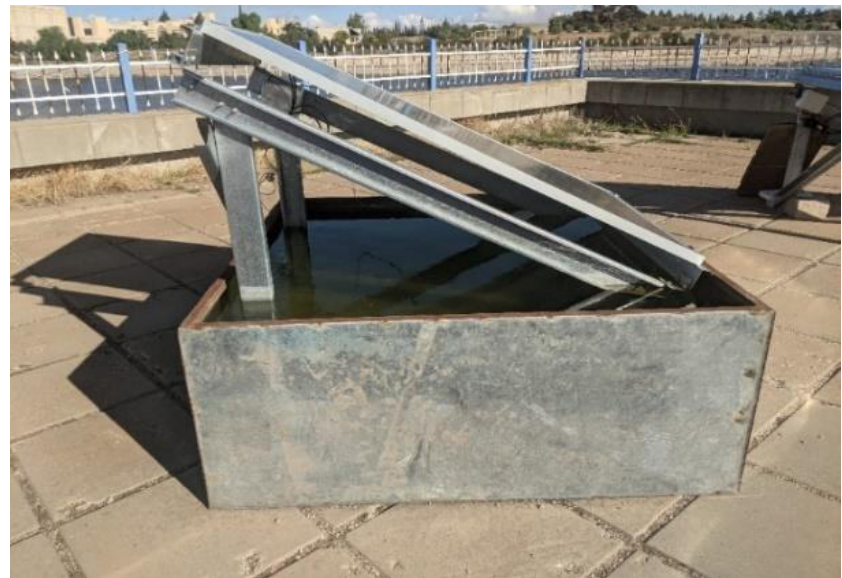
Figure 2. Floating PV panel used in this study.